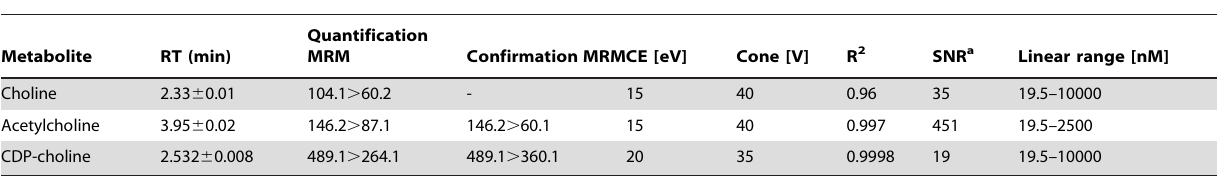
Table 1. Main MS acquisition parameters employed for